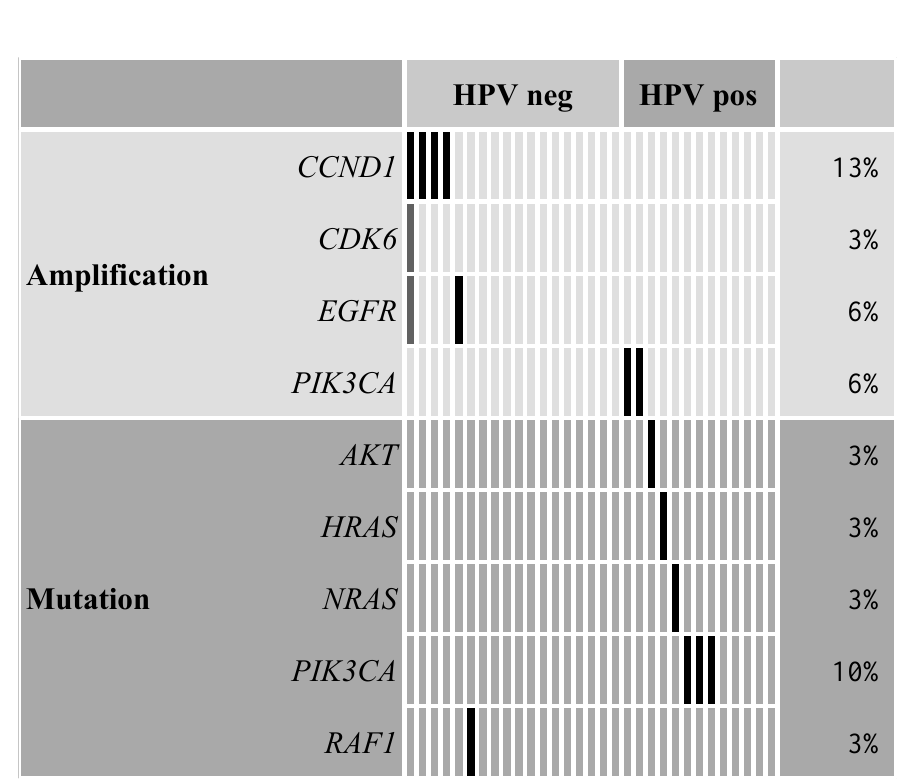
Figure 2. Results of the targeted mutation and amplification analysis using the oncomine panel displayed in an AVAtar graph grouped by HPV status and mutation or amplification. The black bars show the first positive result per sample, while the grey bars depict an additional finding of a target in a specific sample.